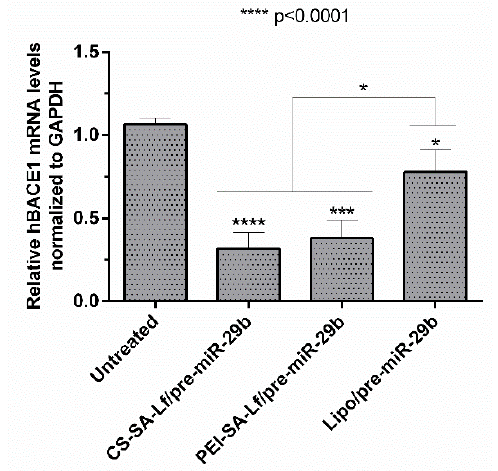
Figure 7. In vitro gene silencing effect of recombinant pre-miR-29b on hBACE1 mRNA levels in N2a695 cells after 72 h treatment with CS-SA-Lf/pre-miR-29b (35 N/P ratio), PEI-SA-Lf/pre-miR-29b (15 N/P ratio) and Lipofectamine 2000 (Lipo)/pre-miR-29b. Values in the graph represent the mean from triplicates of RT-qPCR threshold cycles for hBACE1 mRNA normalized to those of mRNA for GAPDH from three independent experiments and demonstrate significant differences across treatment conditions.